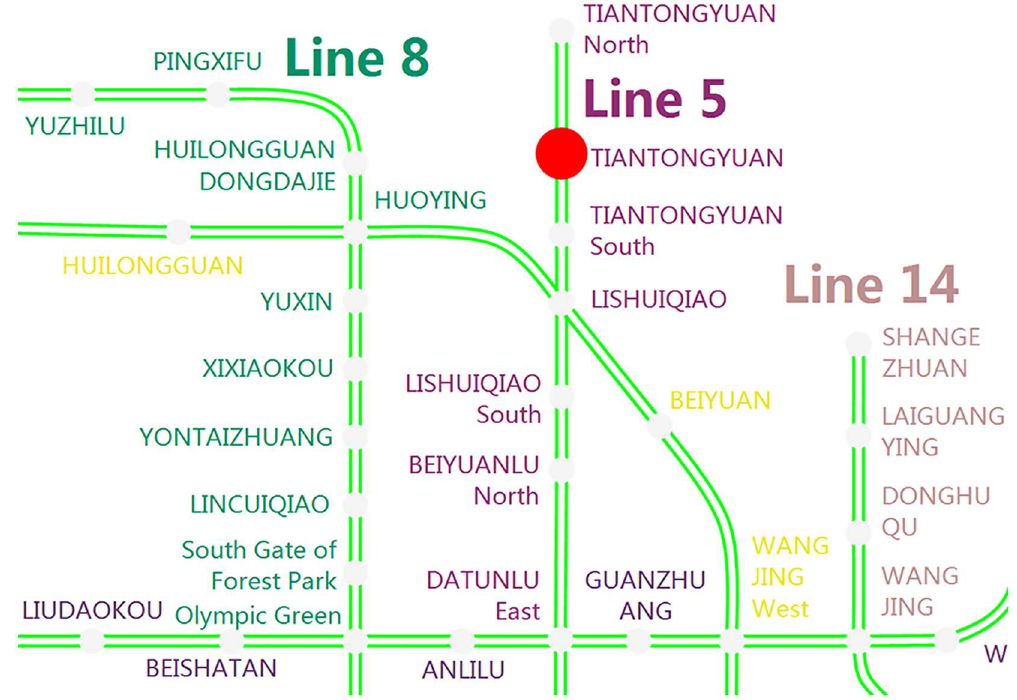
Fig 10. The location of TIANTONGYUAN station in the Beijing rail transit network. The red point is the TIANTONGYUAN station.